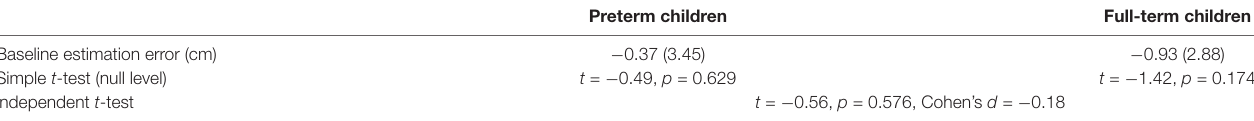
Preterm children